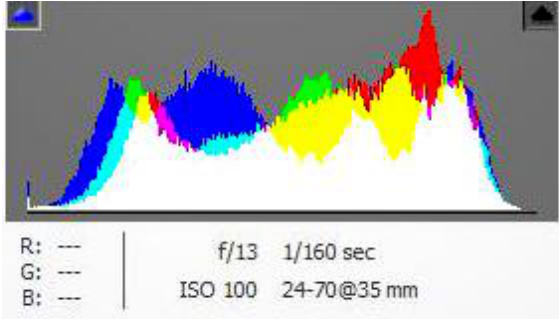
Figure 4. Color histogram camera Nikon d800E